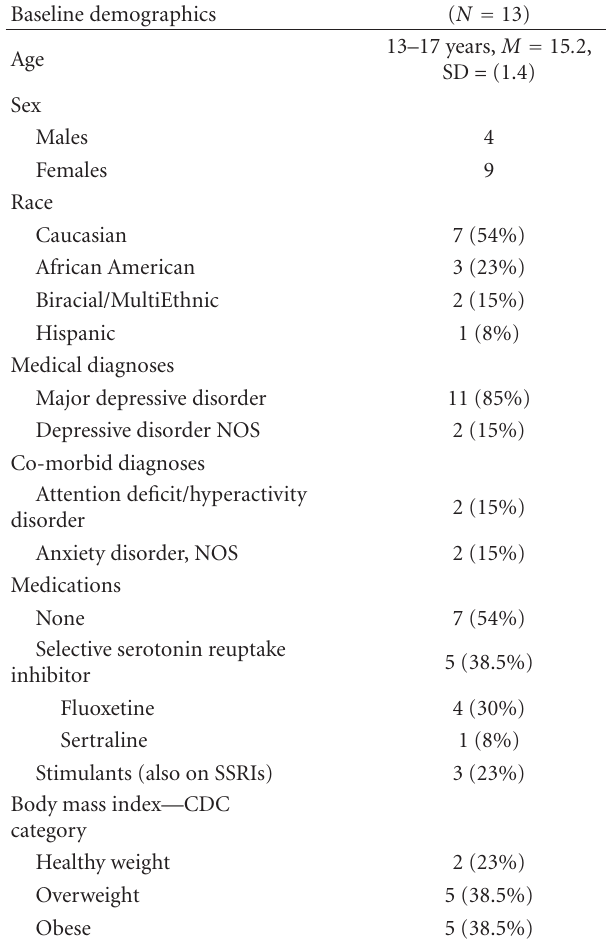
Table 1: Demographic characteristics of participants at